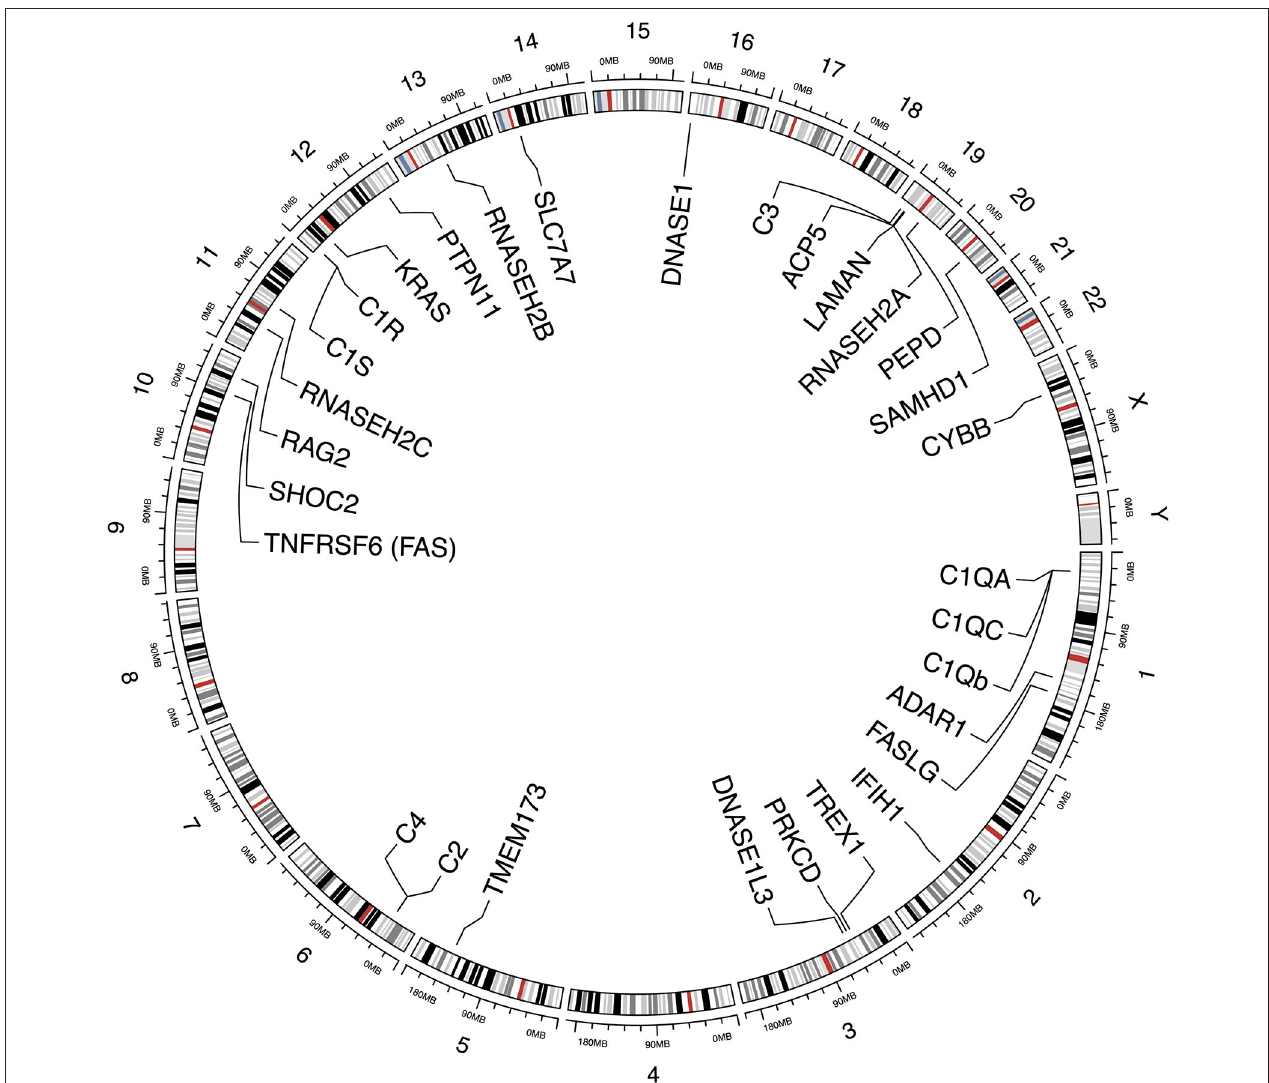
FIGURE 1 | Schematic representation depicting genes and chromosomal locations previously identified to be implicated in monogenic lupus. This figure was produced using ‘circlize’ in R